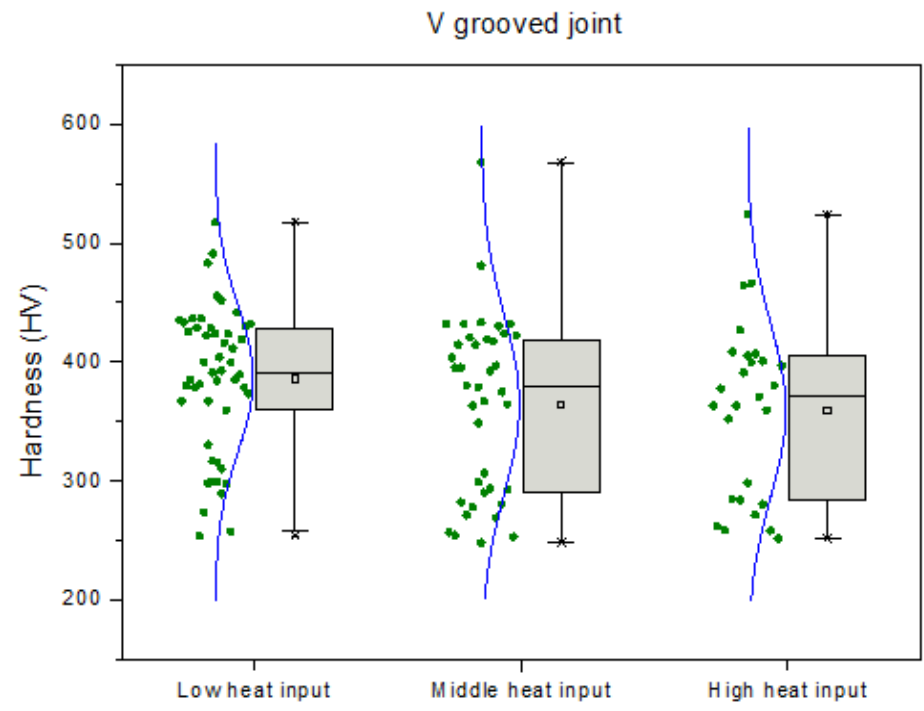
Figure 11. Hardness analyses results of FCAW with heat input in butt joint.